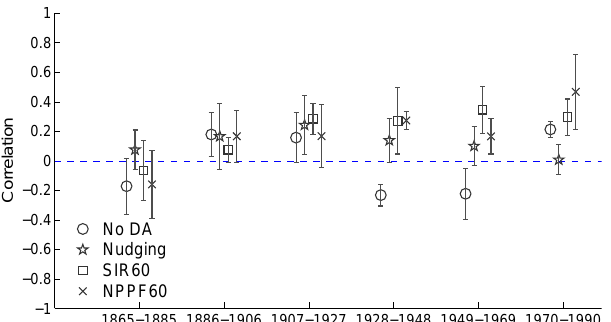
Fig. 10. Same as Fig. 8, but for geopotential height.